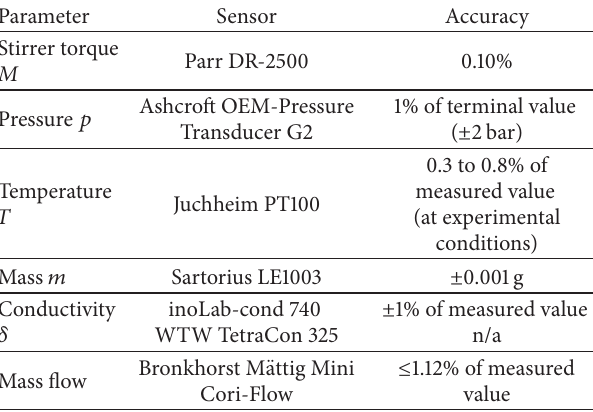
Table 2: Measurement variables and accuracy; Parr